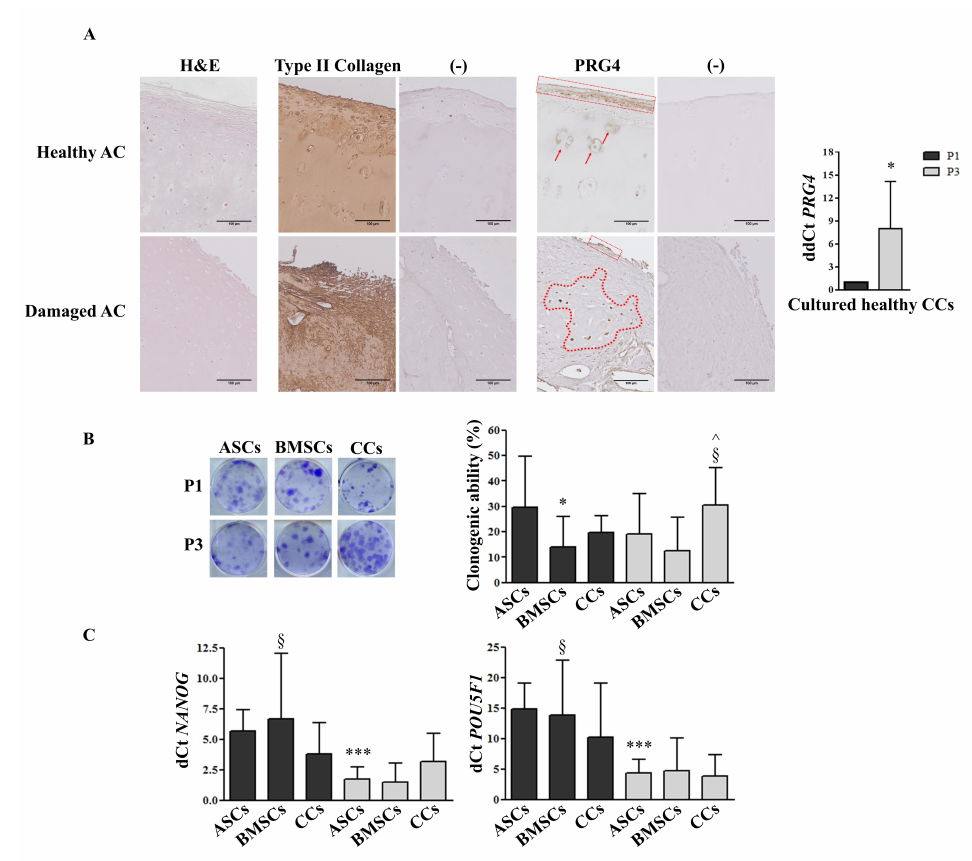
Figure 1. PRG4 expression, clonogenic ability, and stemness marker expression. ( A ) Representative immunohistological distribution of type II collagen and PRG4 in healthy and damaged AC (scale bars correspond to 100 µ m), and PRG4 expression in culture-expanded CCs ( n = 4). ( − ) indicates negative control (secondary antibody only). ( B ) Clonogenic ability and ( C ) stemness marker expression of adipose (ASCs), bone marrow (BMSCs)-derived MSCs and cartilage cells (CCs) obtained from the same eight donors. Cells were analyzed at passage 1 (P1) and passage 3 (P3). * p < 0.05, *** p < 0.001 vs. ASCs at P1, § p < 0.05 vs. BMSCs at P3, ˆ p < 0.05 vs. CCs at P1. Data are represented as mean ± SD ( n =